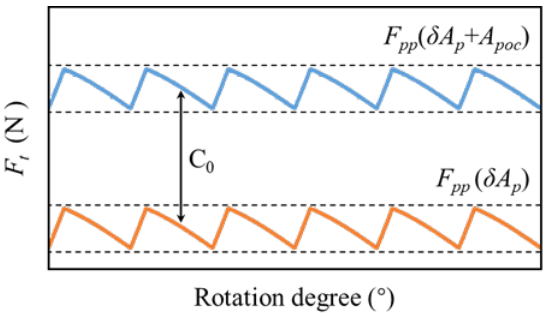
Figure 5. The periodicity characteristics of force fluctuation.